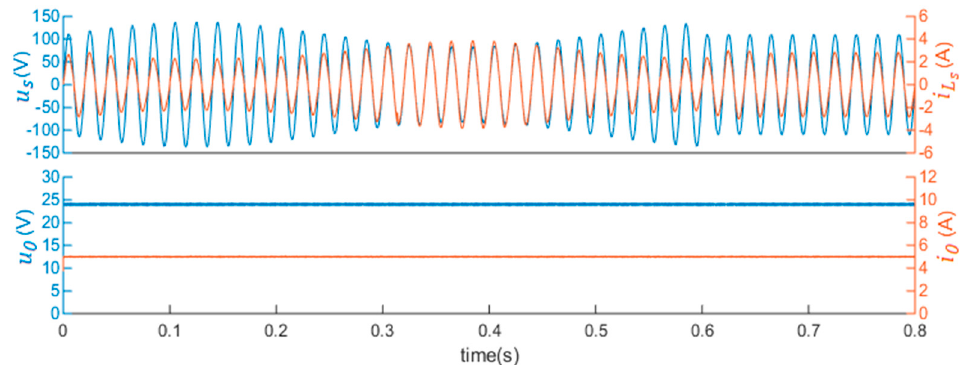
Figure 5. Simulation waveforms for variation in amplitude of AC main voltage.